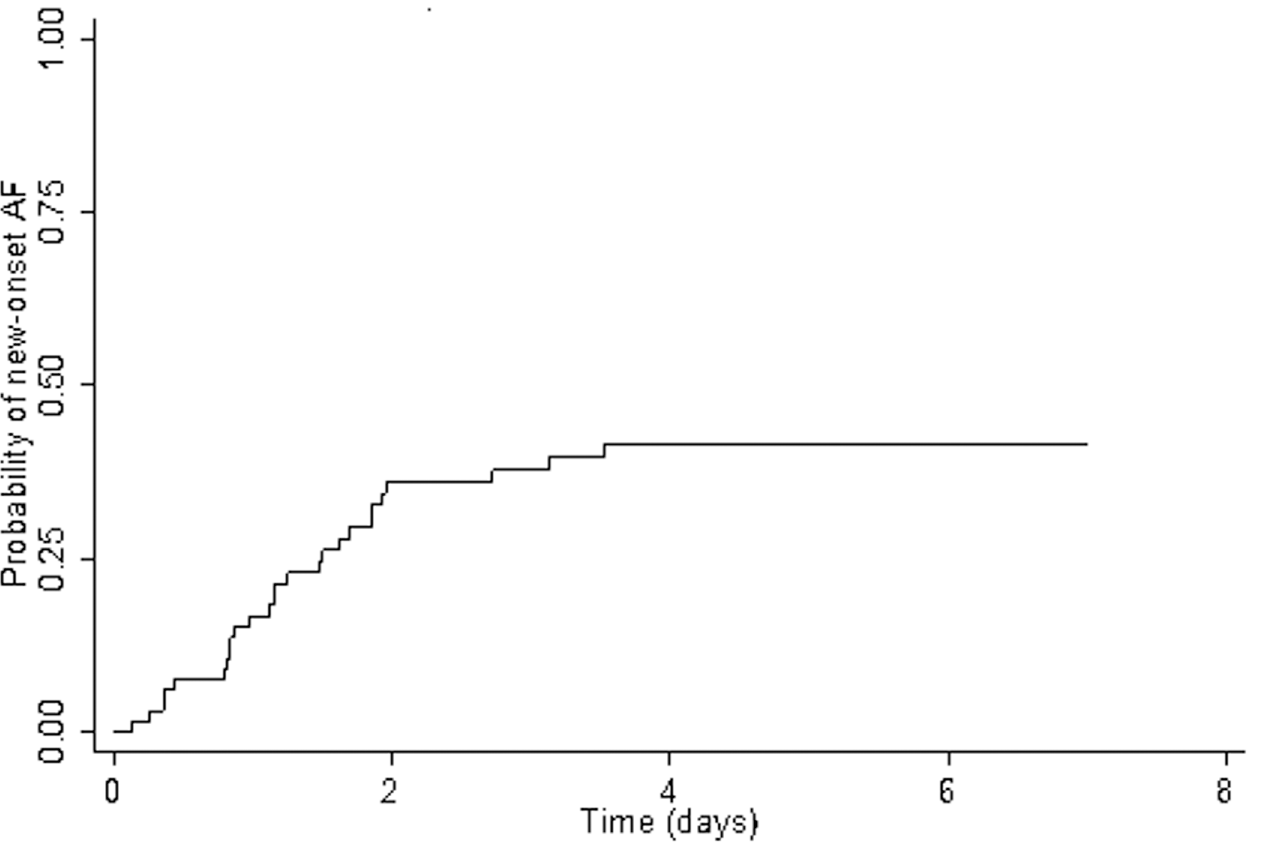
Fig 1. Probability of new-onset AF during the 7 first days of septic shock (Kaplan-Meier